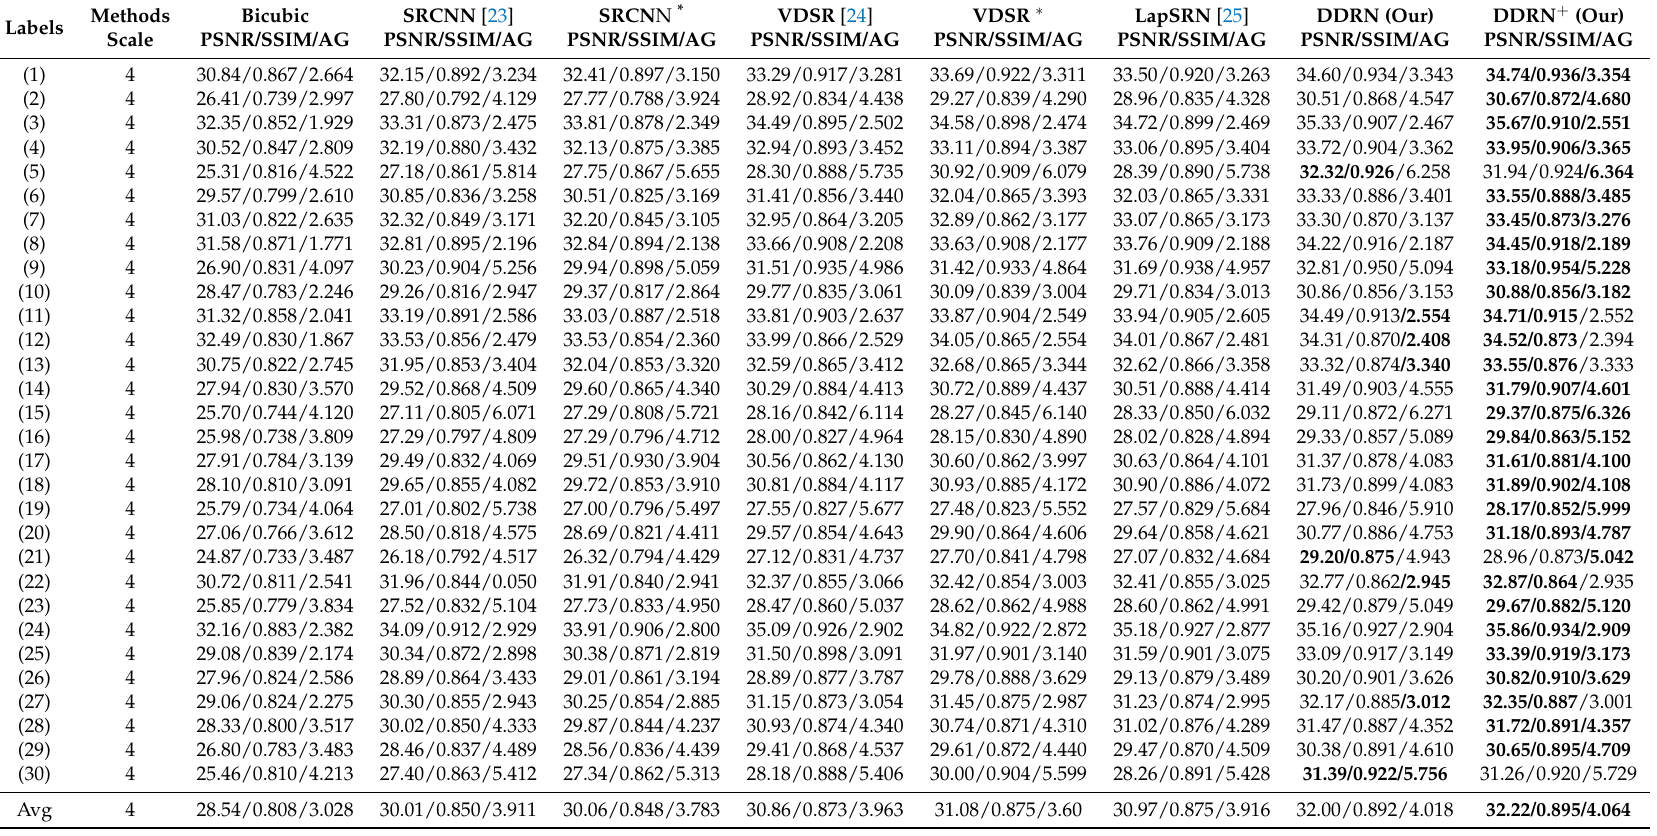
Table 3. Comparison results of the proposed DDRN approach and its improved version DDRN + with some state-of-the-art algorithms on Kaggle Open Source Dataset for the scale factor of 4. Bold indicates the best performance. Particularly, ∗ refers to the modules retrained by us with Kaggle Open Source Dataset